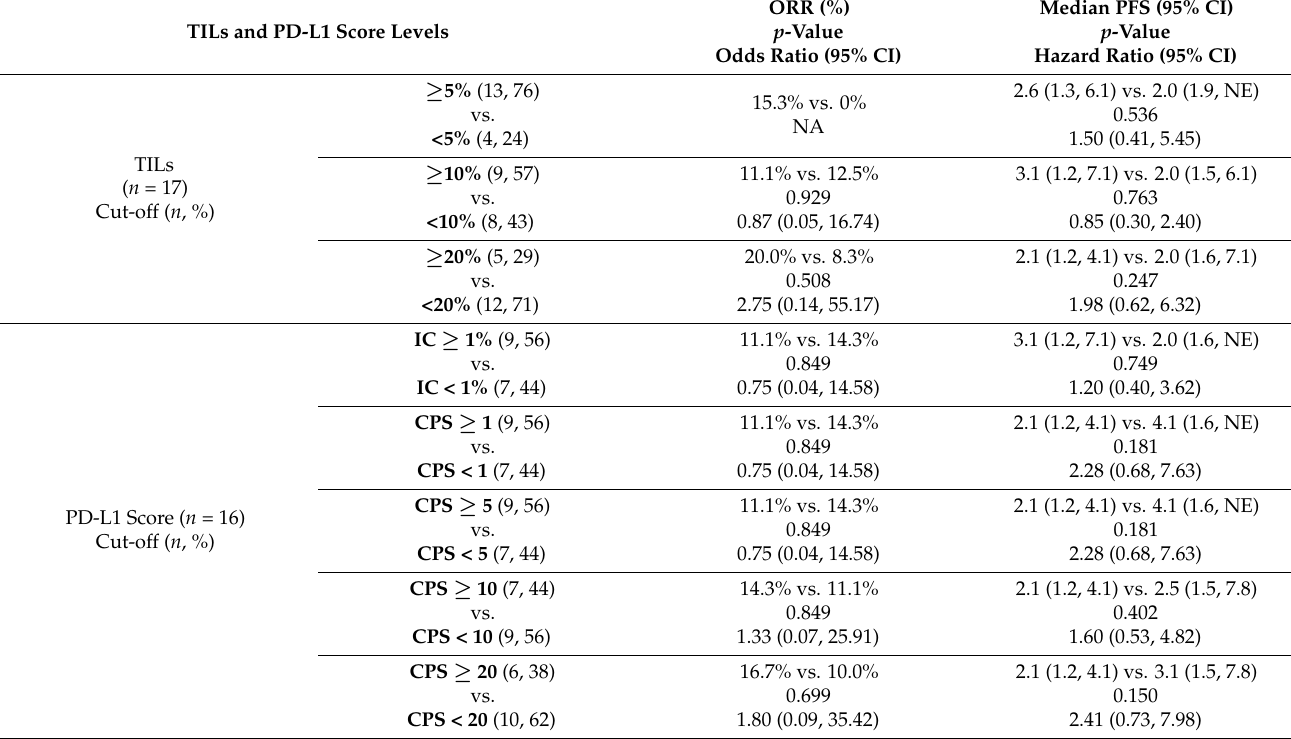
Table 3. ORR and PFS according to different TILs, PD-L1 and combined TILs/PD-L1 cut-offs. Logistic and Cox regression models have been used to analyze the association between TILs density and PD-L1 expression (IC and CPS scores) with OR (CR + PR) and PFS. Median PFS were calculated by Kaplan–Meier.